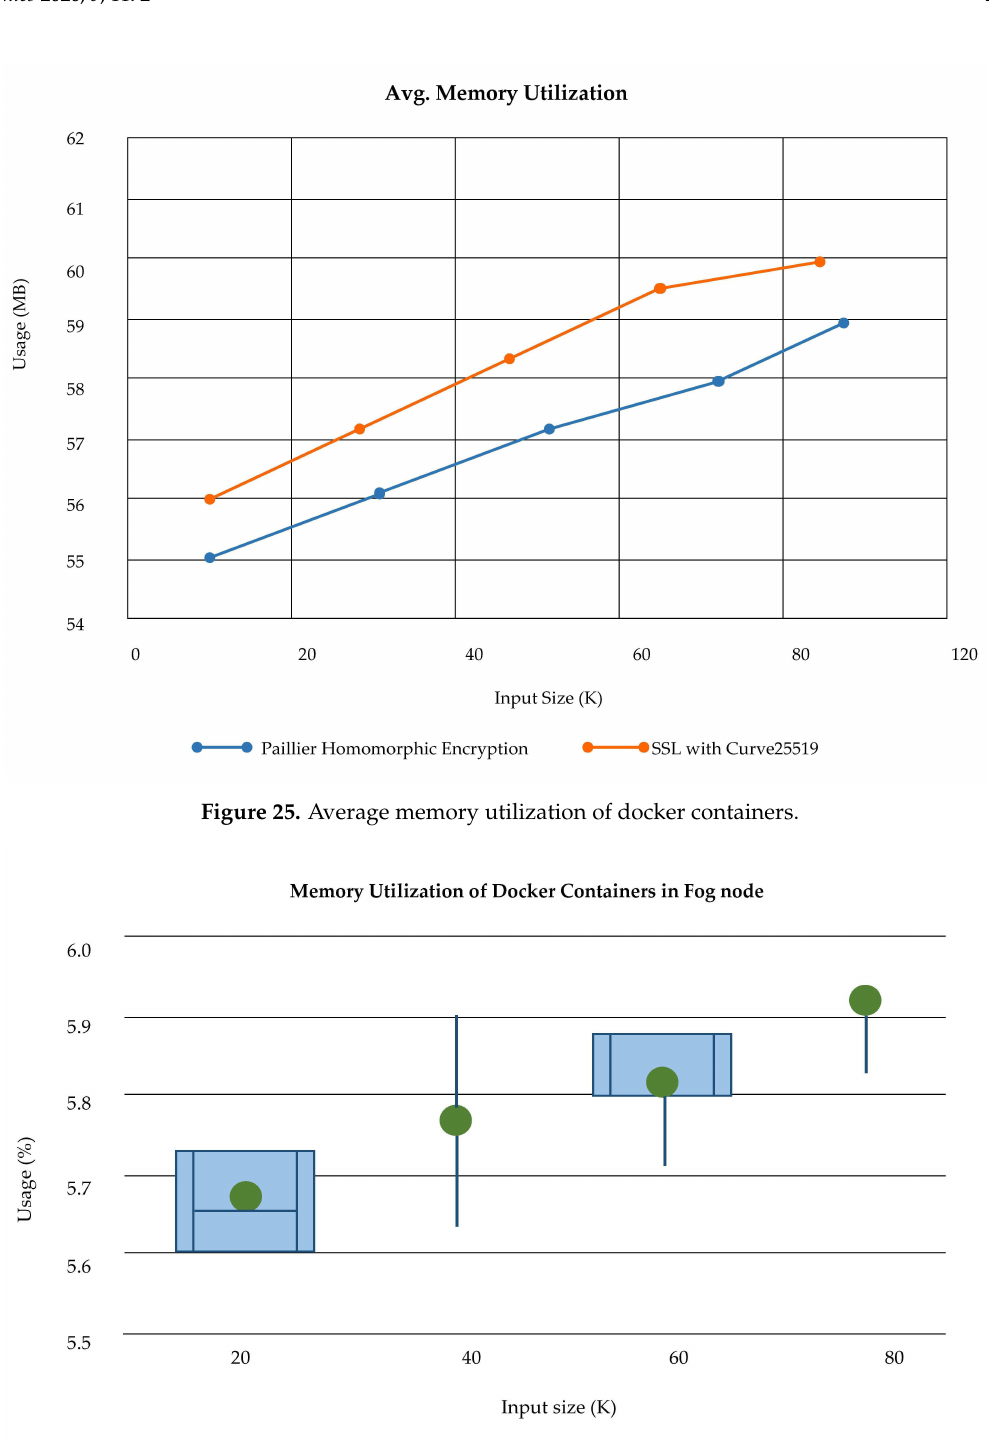
Figure 26. Average memory utilization of docker containers in fog